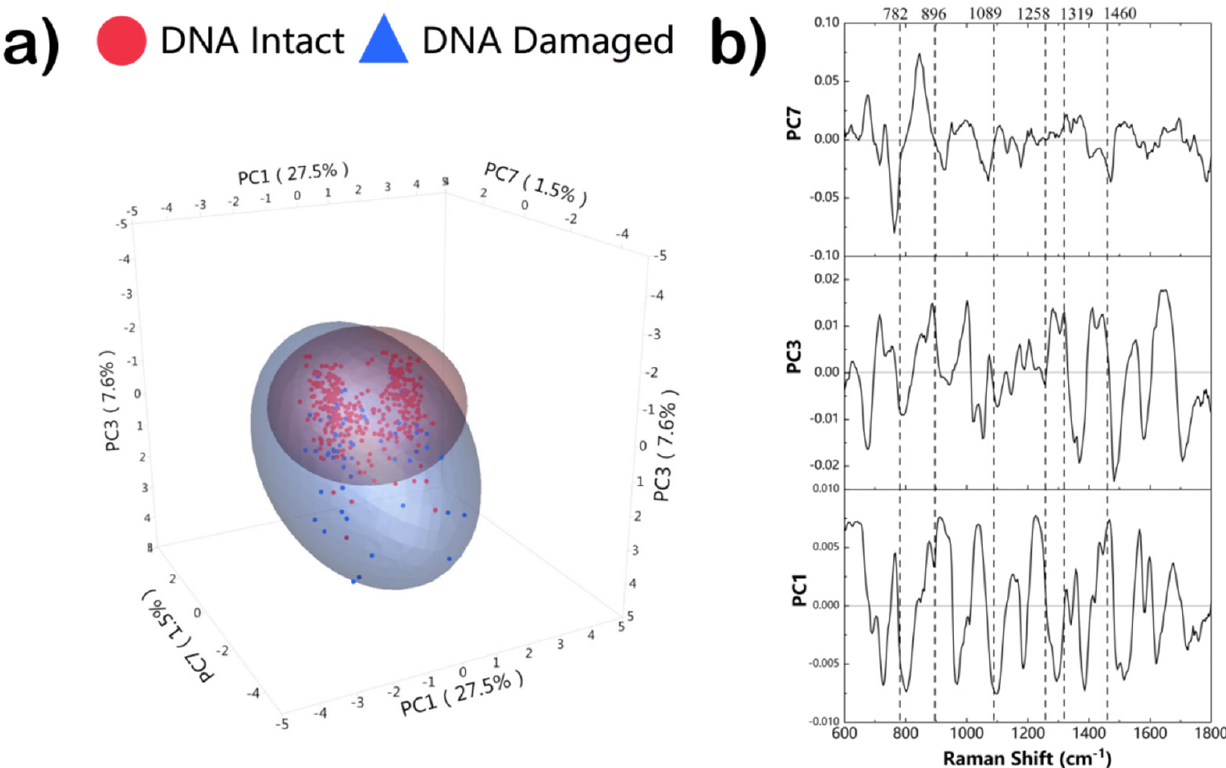
Figure 4. ( a ) Three-dimensional scatter plots of sperm DNA Intact (blue triangle) and DNA damaged (red circle). Ellipsoids represent 95% of data coverage; ( b ) The loading plot shows three (PC1, PC3, and PC7) of the principal components of the sperm Raman spectra. Table 2. Comparison of discrimination Performance of the DNA-damaged and DNA-intact sperm cells, validated with LOOCV and k-fold